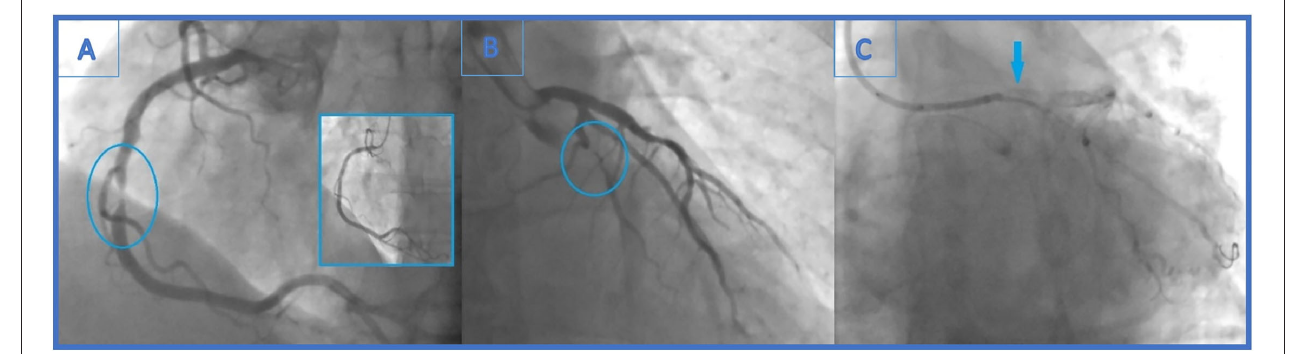
FIGURE 1 | (A) Urgent coronary angiography with significant mid-right coronary artery stenosis (99%)-the culprit lesion and final angiographic result in the little window. (B) Distal left circumflex artery (LCx) lesion left unsolved (90% stenosis). (C) Angiogram showing stent falling from the balloon and darting into the LCx ostium. It is seen as linear radio-opaque object in the